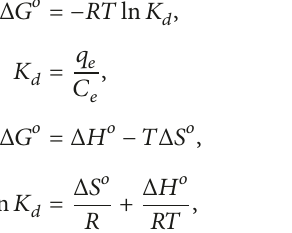
Figure 6: Effect of adsorbent dosage.